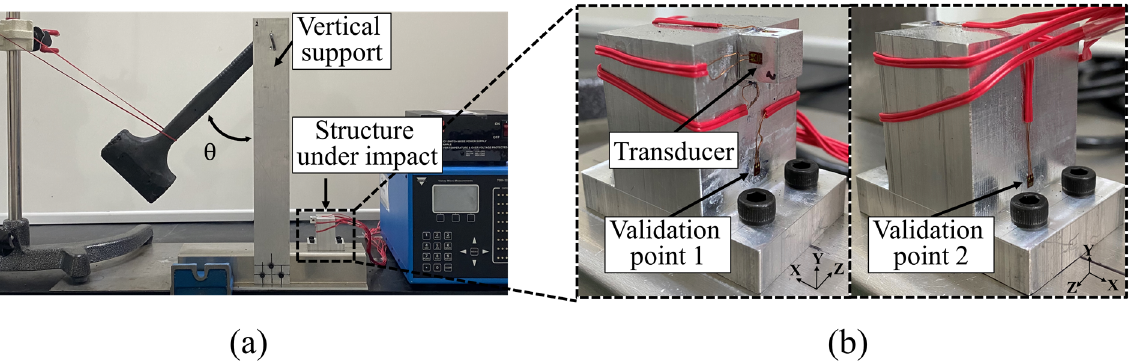
Figure 2. Experimental set-up. ( a ) Experimental set-up for measuring transducer and structural strain due to impact; ( b ) structure installed with impact load transducer and strain gauges (y-axis) for